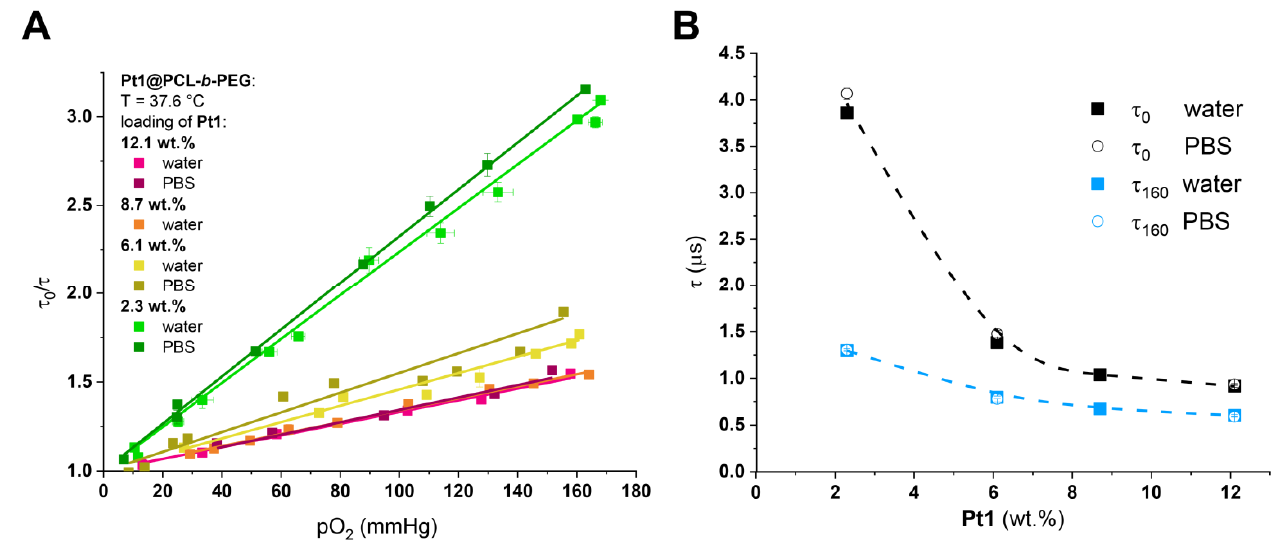
Figure 3. ( A ). Stern–Volmer plots for Pt1@PCL- b -PEG of various Pt1 loadings in water and PBS. ( B ). Dependence of lifetime in fully degassed (extrapolated to 0 mmHg O 2 ) and aerated (interpolated to 160 mmHg O 2 ) on composition of Pt1@PCL- b -PEG in PBS dispersions at 37.6 ◦ C. Lifetime data were acquired at 605 nm, λ exc = 365 nm.